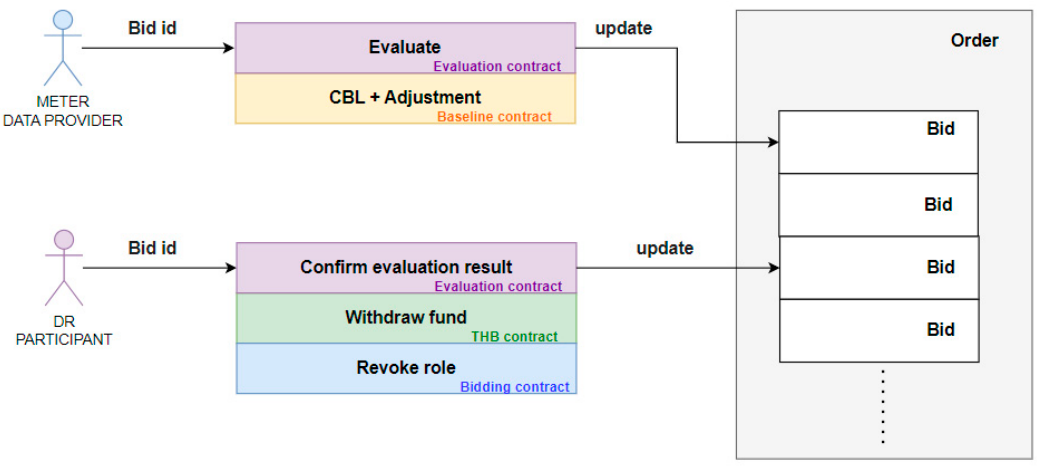
Figure 6. Evaluation system.